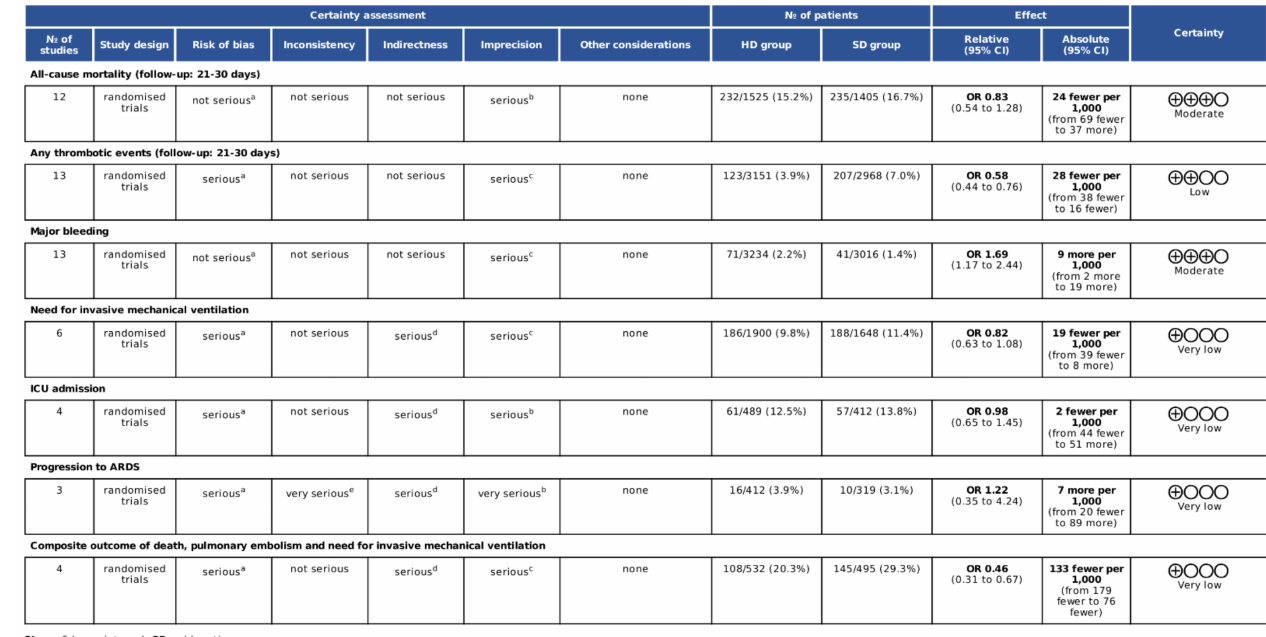
Figure 7. GRADE assessment of the included studies. a The included studies are open-label studies, some of them with blinded adjudication. All-cause mortality and major bleeding are objective outcomes are thus less influenced by a lack of allocation concealment. b Some studies included a small sample size and low number of events. The 95% confidence interval is wide and crosses the line of no effect. c Some of the studies included a small sample size and low number of events. d There were some differences in outcome measures. Need for invasive mechanical ventilation, ICU admission, progression to ARDS, and the composite outcome included a subjective clinical decision—this and the open-label design could have influenced the measurement of the outcomes. e There were wide differences in point estimates across